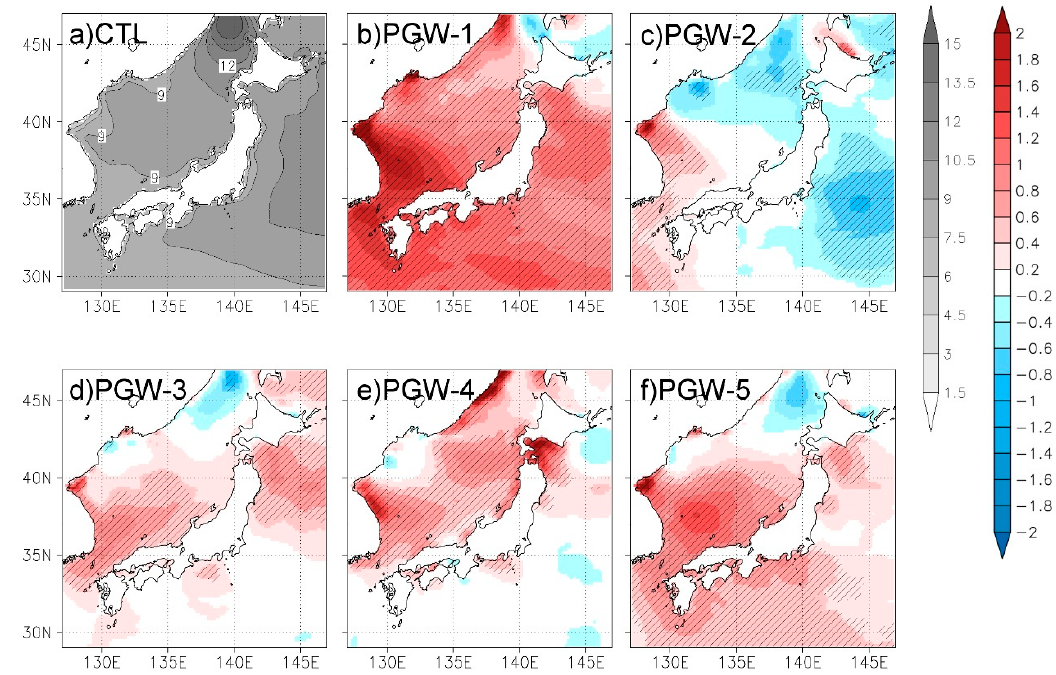
Figure 5. Spatial distribution of mean wind speed. ( a ) Climatological mean winter wind speed ( U 10 ) of CTL, and ( b )–( f ) future variations of U 10 in each PGW simulation. Left-hand color bar is for U 10 in CTL and right-hand color bar is for future variations of U 10 . Unit of color bars is m / s. Areas with statistically significant variation are indicated by hatching.